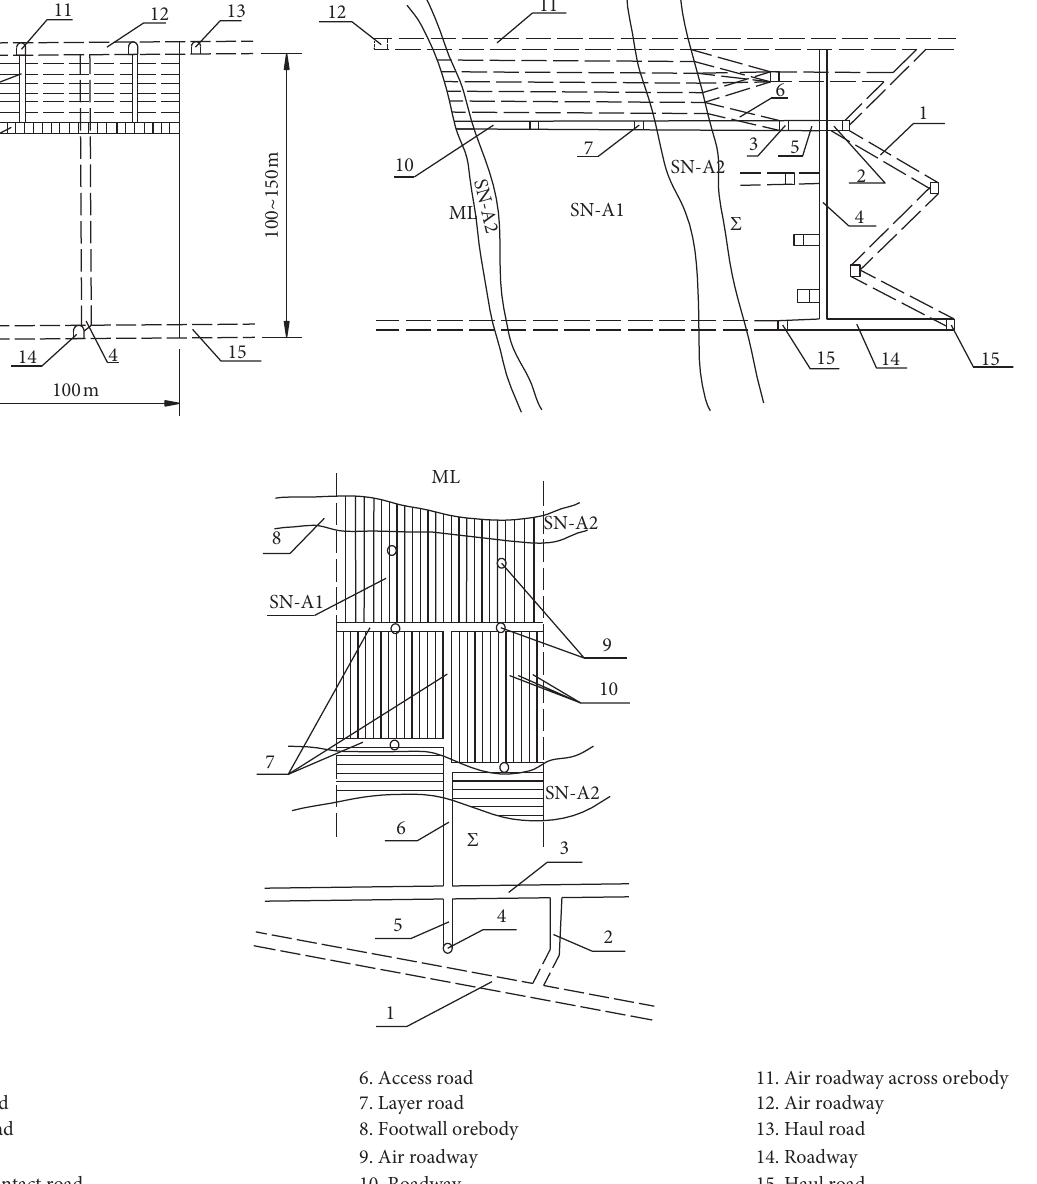
Figure 2: Design of the mechanized panel downward mining